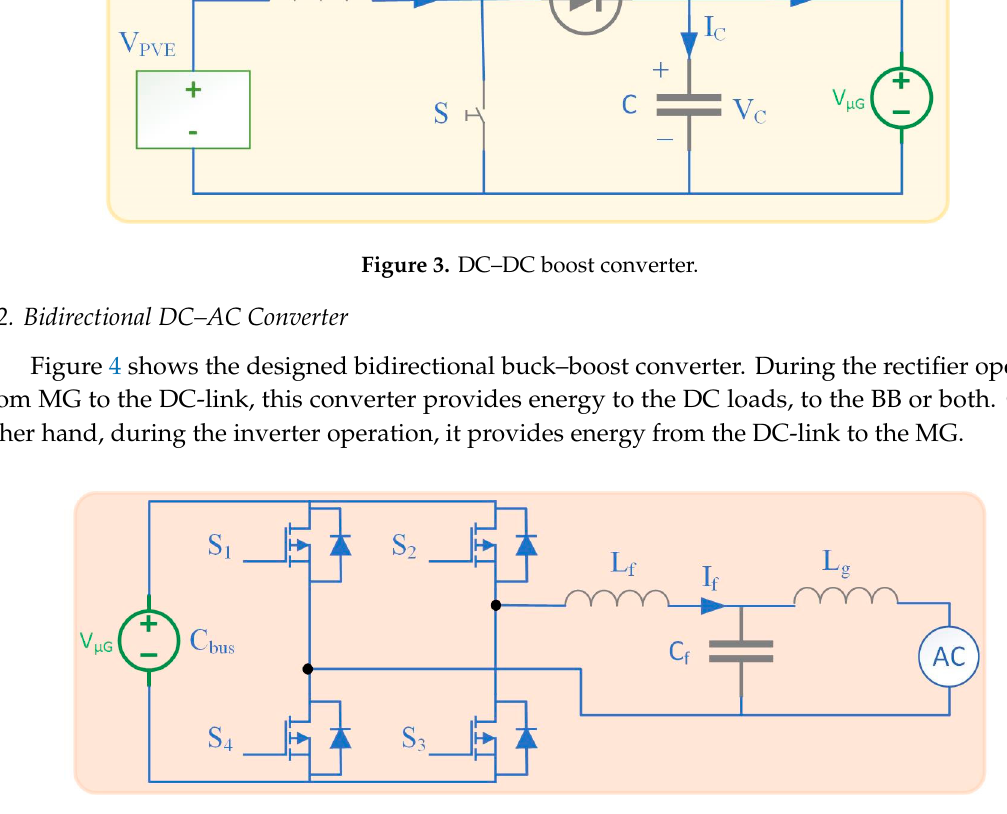
Figure 4. Bidirectional DC–AC converter.